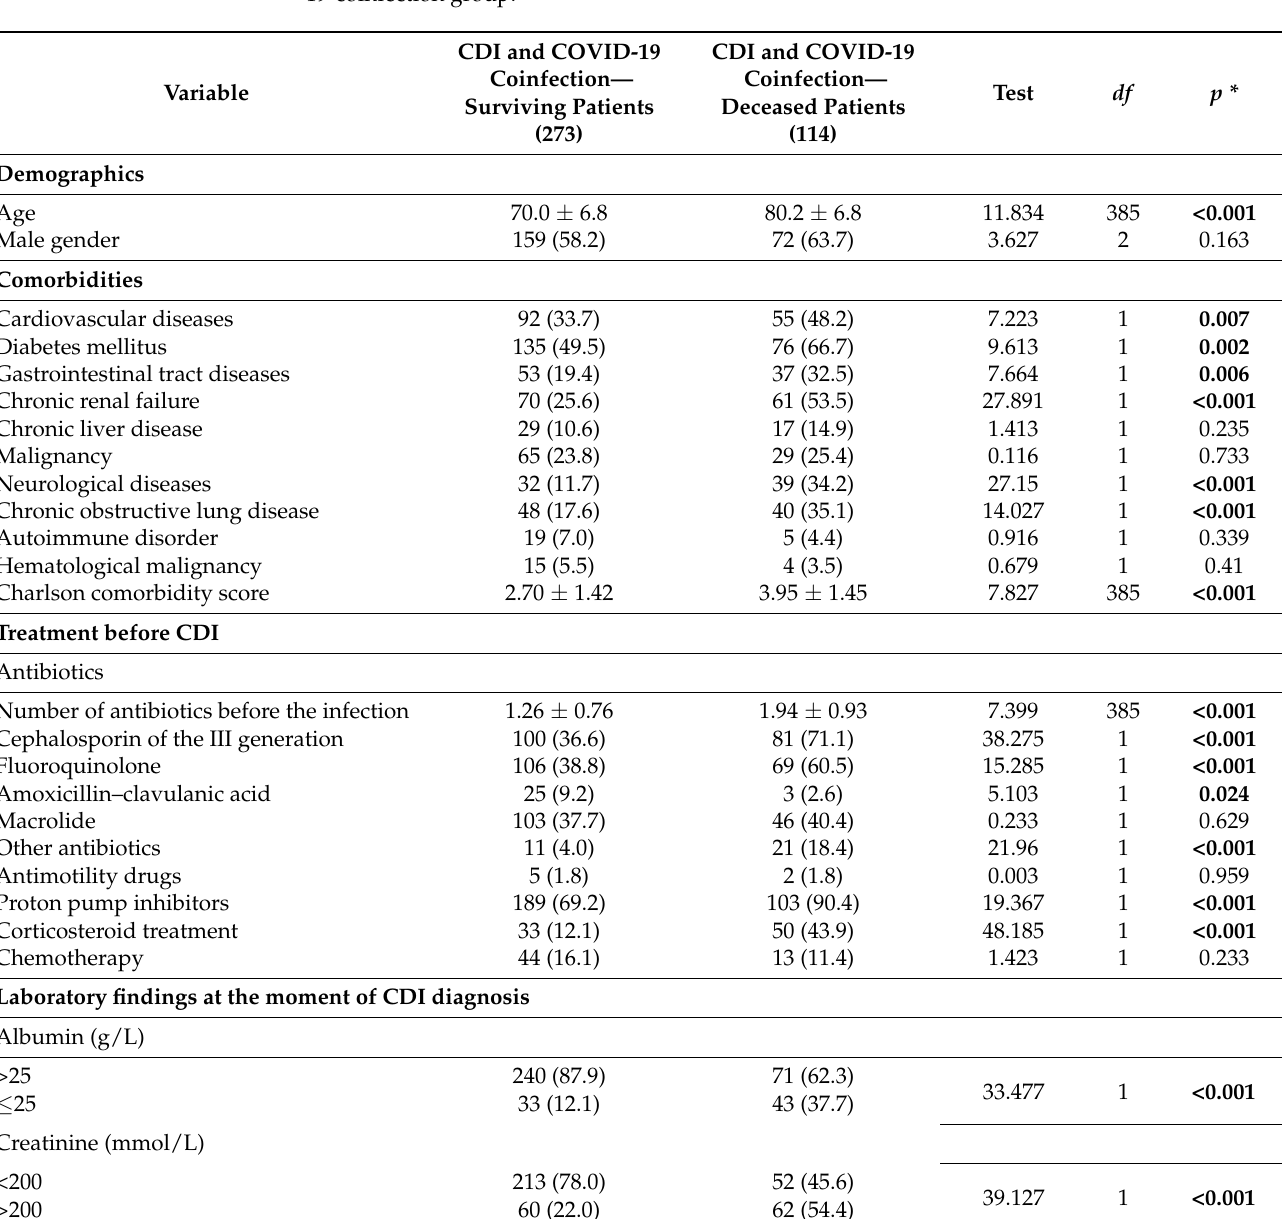
Table 4. Demographic characteristics, previous and concomitant medication use, and laboratory parameters at the time of CDI diagnosis in surviving and deceased patients in the CDI- and COVID- 19-coinfection